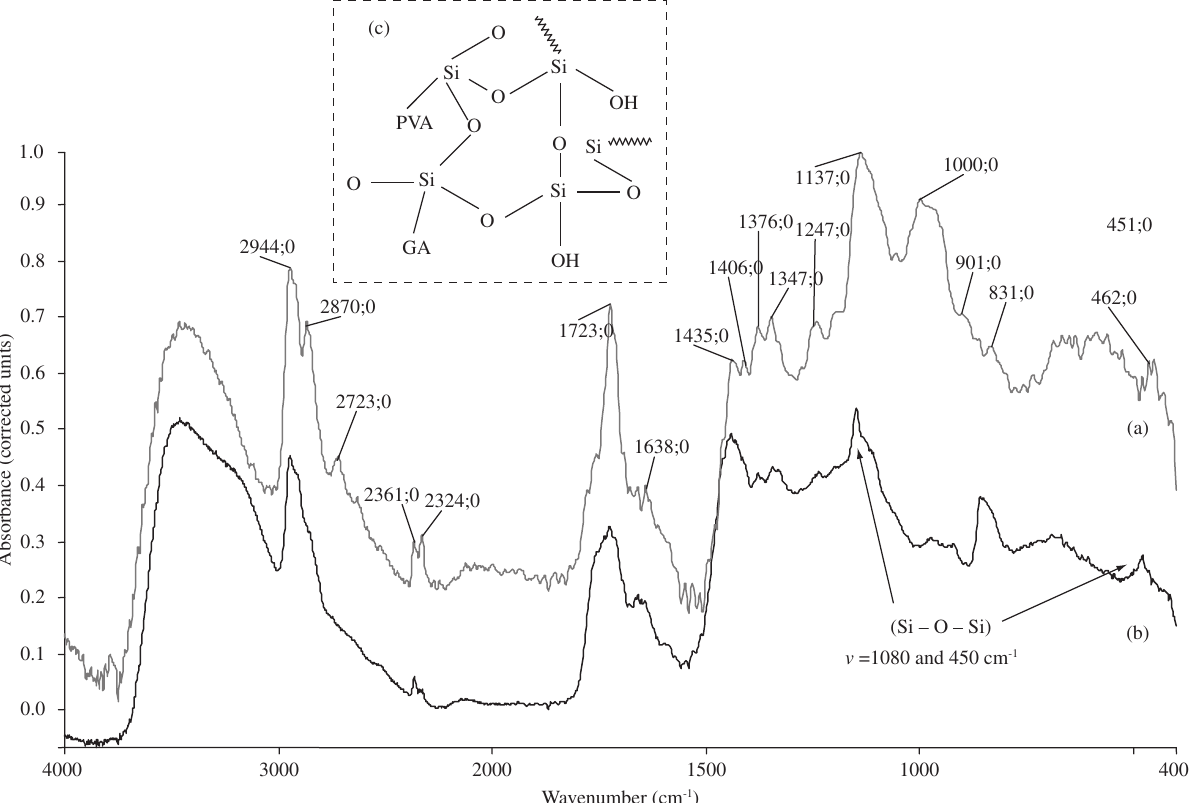
Figure 4. FTIR spectrum of a) PVA/TEOS/GA hybrid; b) PVA/TEOS/GA hybrid; and c) schematic representation of PVA/TEOS/GA hybrid nanostructure.